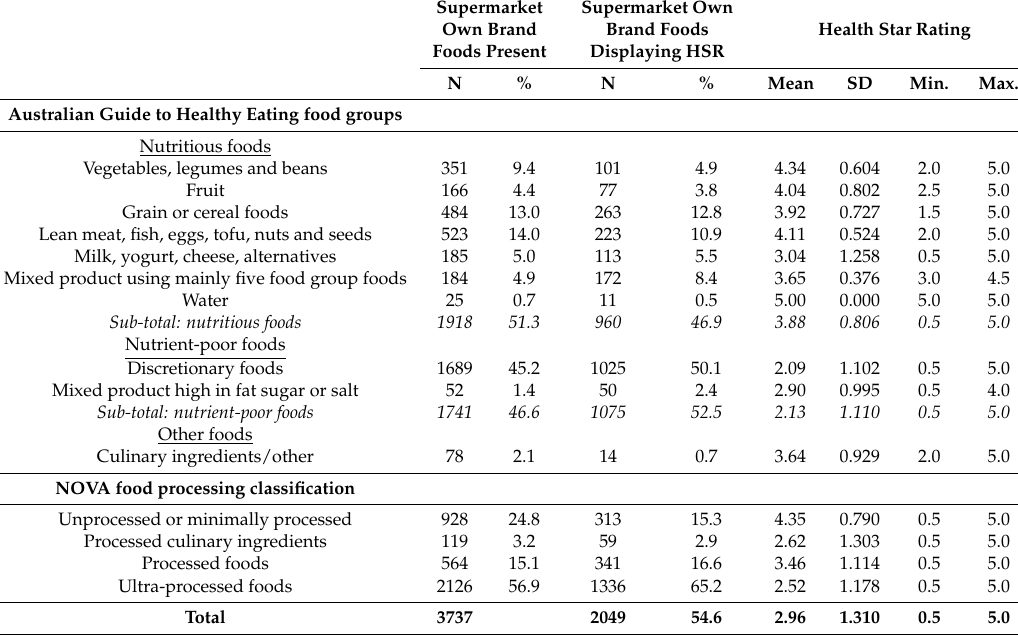
Table 3. Health Star Rating scores for supermarket own brand foods in Australia, classified by nutritional